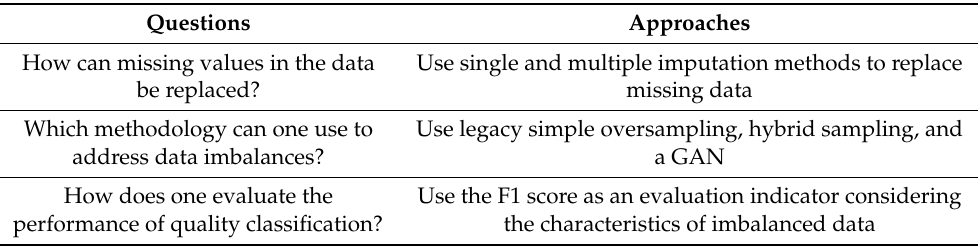
Table 1. Research questions and